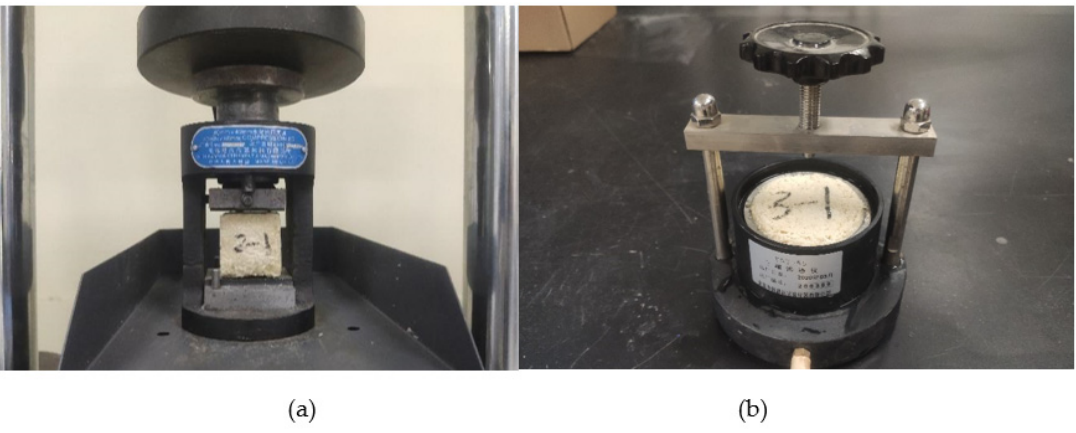
Figure 2. Chemical grouted sands performance test: ( a ) compressive strength test; ( b ) permeability coefficient test.